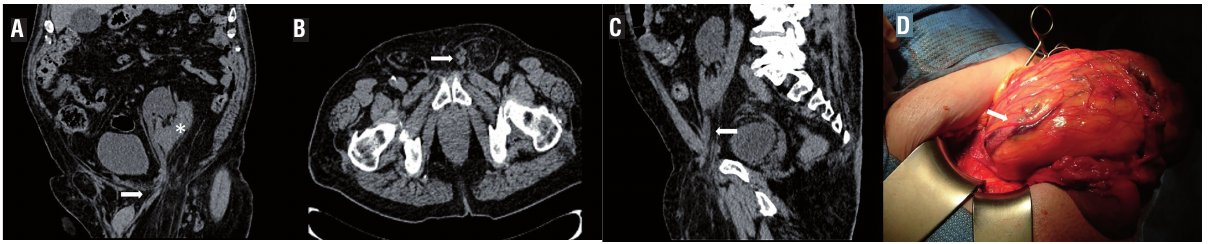
Figure 1 - A) Coronal abdominal non-contrast-enhanced CT scan showing dilated left pelvic kidney (asterisk) and dilated ureter (arrow) in the inguinal hernia. B) Axial non-contrast-enhanced CT scan with loop of the left ureter in the hernia (arrow). C) Sagittal non-contrast-enhanced CT scan with ureteral inguinoscrotal hernia (arrow). D) Identification of left ureter (arrow) during the inguinal hernia